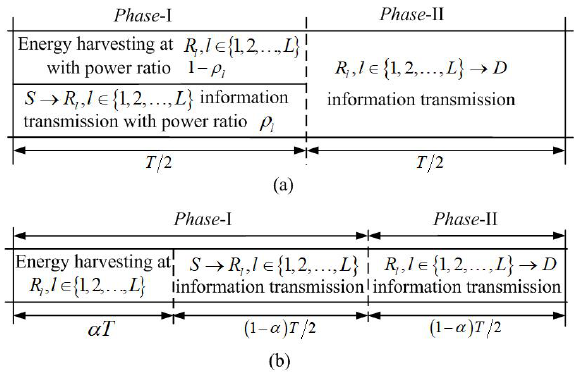
Figure 2. Time slot structure for TS and PS schemes: ( a ) PS scheme, ( b ) TS